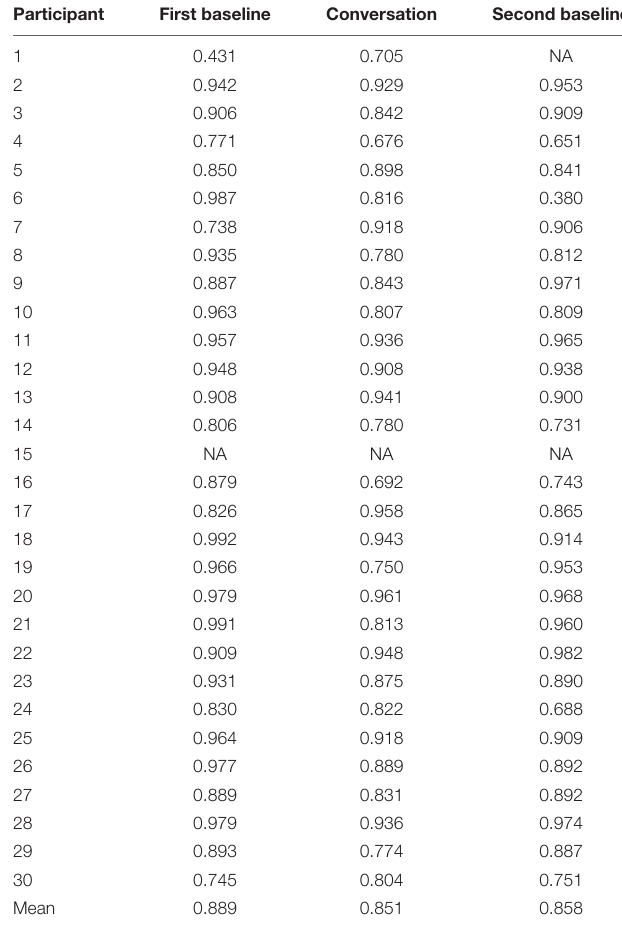
TABLE 4 | Intra-participant correlations between IBI time-series obtained by the E4 and by the MW mobile device, in each of the three segments. Participant First